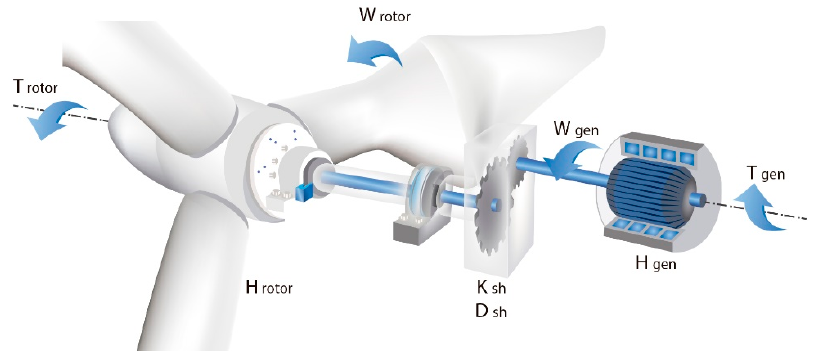
Figure 2. Two masses model for wind turbine.